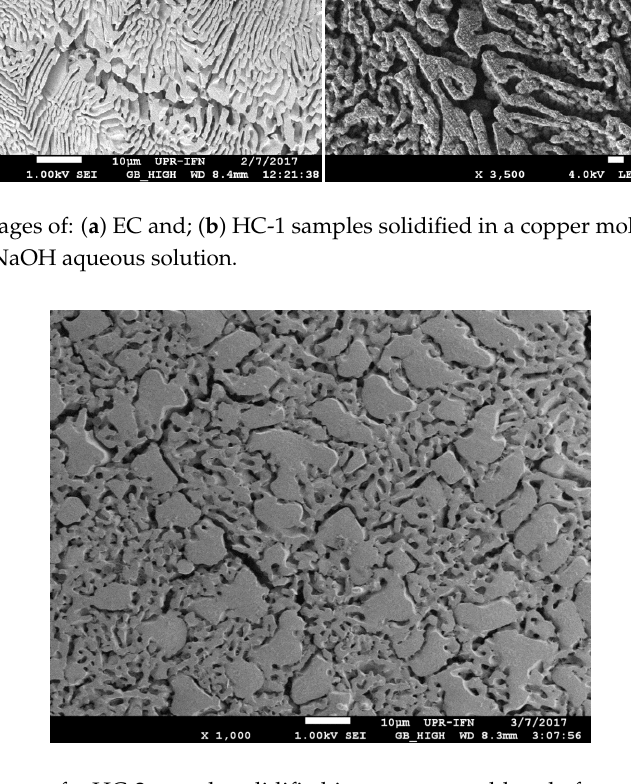
Figure 3. SEM image of a HC-2 sample solidified in a copper mold and after corrosion for 24 h in 10 vol. % NaOH aqueous solution.